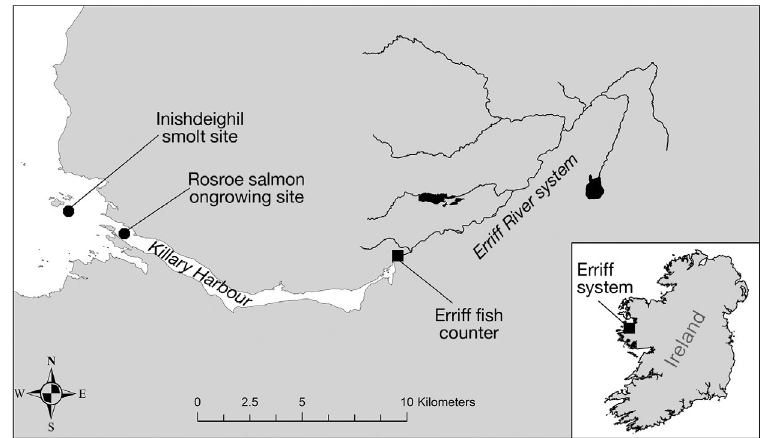
Fig. 1. Erriff River system and Killary Harbour, Ireland, showing the location of the salmon aquaculture sites and the fish